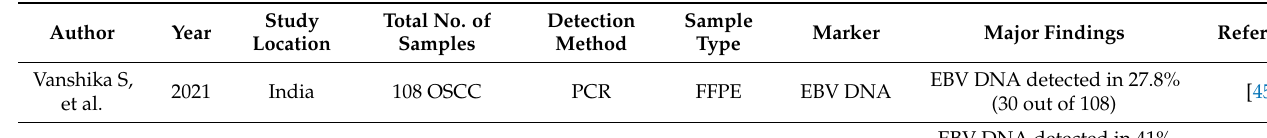
Table 1. Clinical studies on detection of EBV in OPMD and